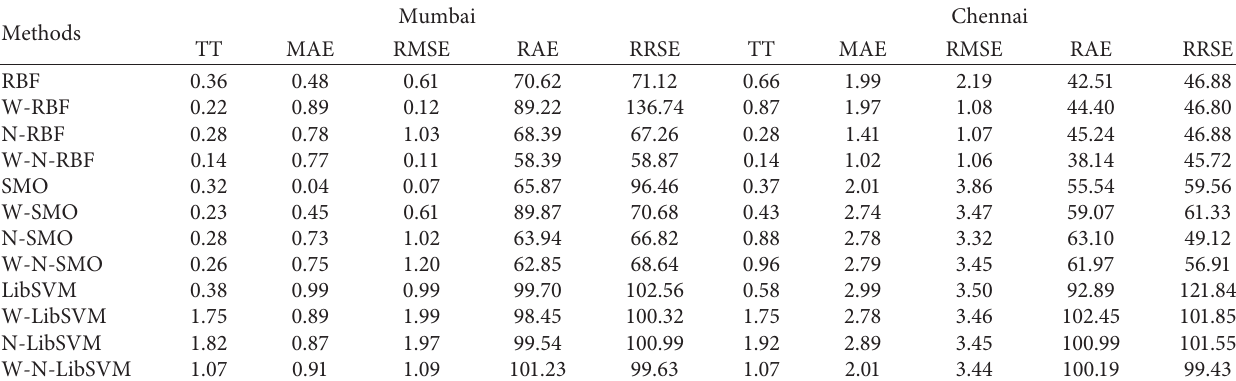
Table 6: Comparison of errors and time taken for maximum temperature, Mumbai and